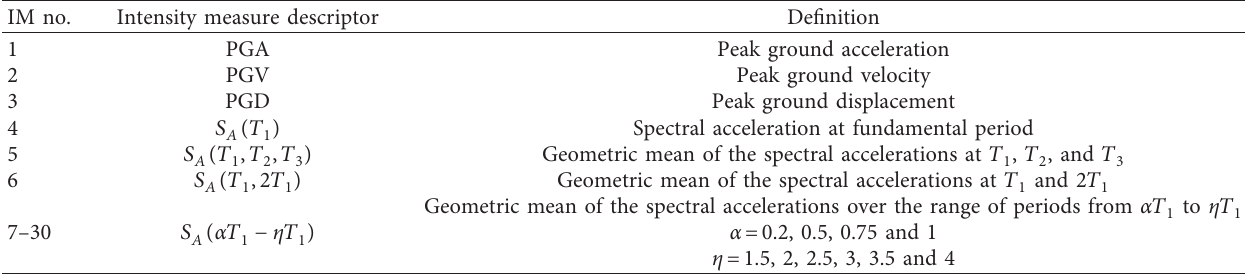
Table 5: Intensity measures considered in the